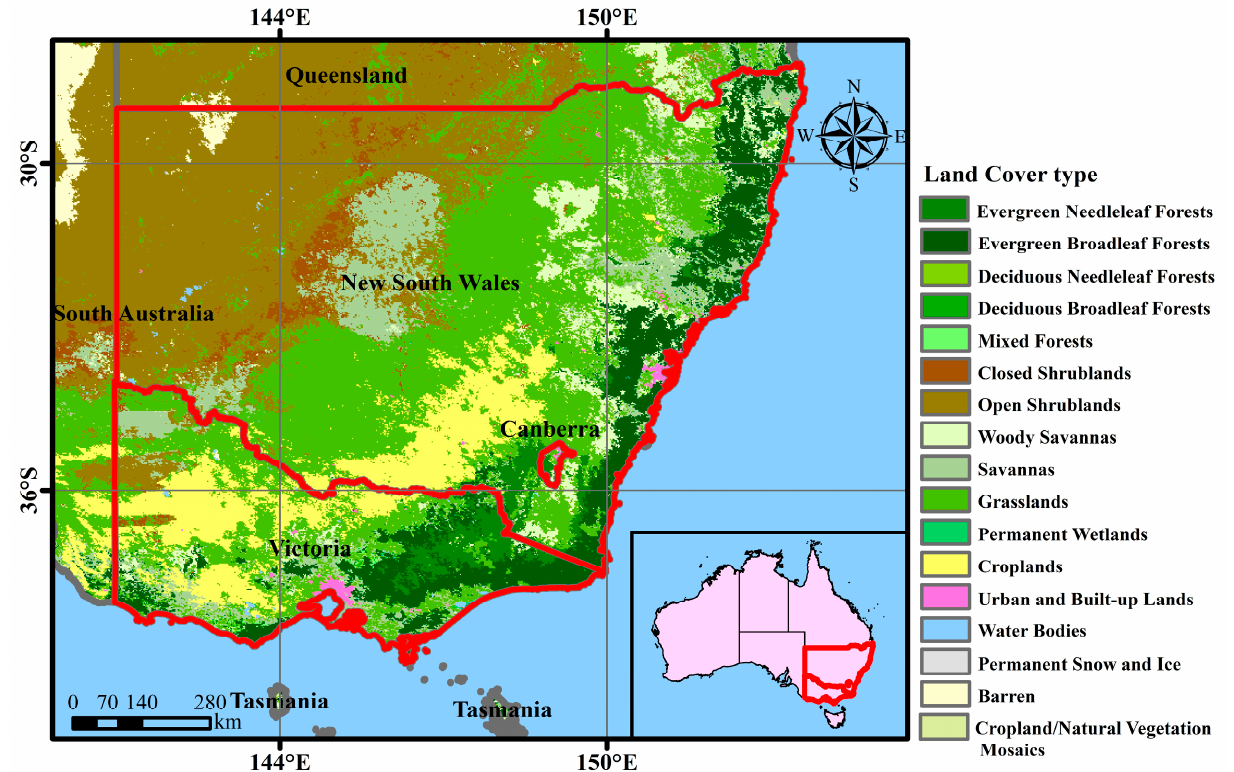
Figure 1. The spatial extent of the study area. The land cover is taken from MODIS 500 m Land Use/Land Cover (LULC) production for 2020.